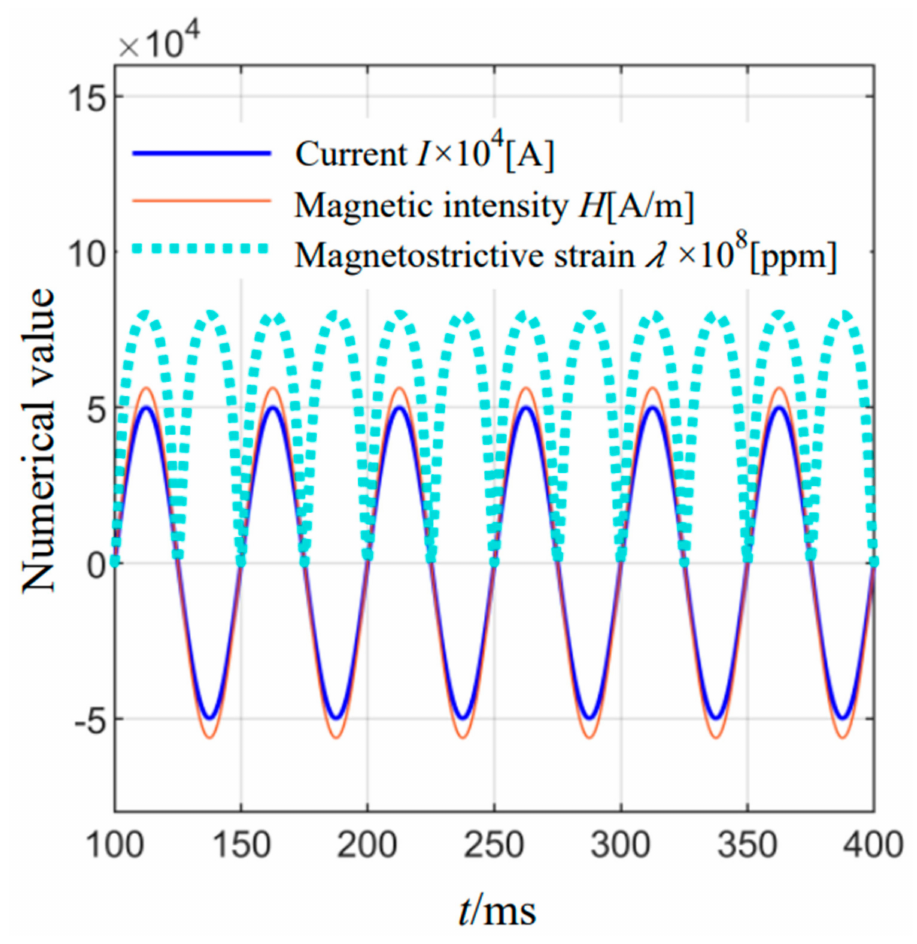
Figure 13. Solving some intermediate variables of GMA